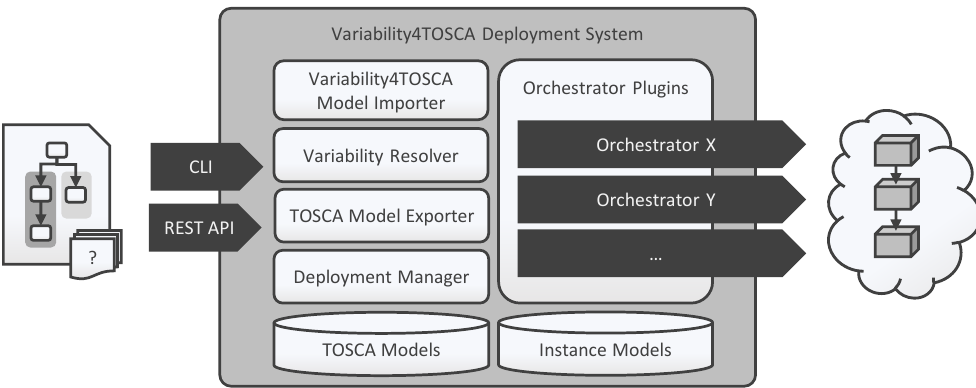
Figure 5. System architecture of a Variability4TOSCA Deployment